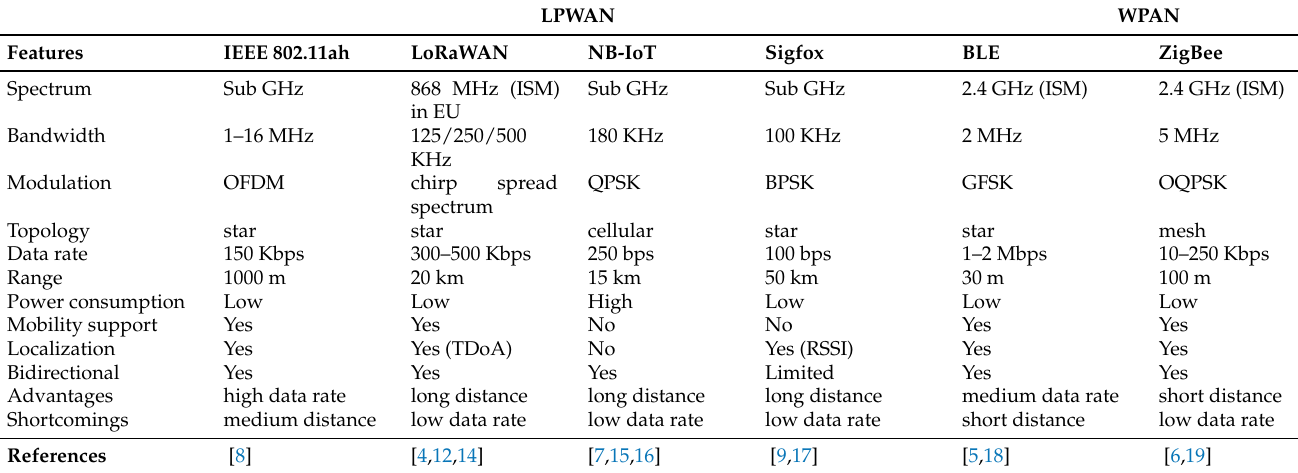
Table 1. A comparison between IEEE 802.11ah and current wireless technologies for IoT. LPWAN